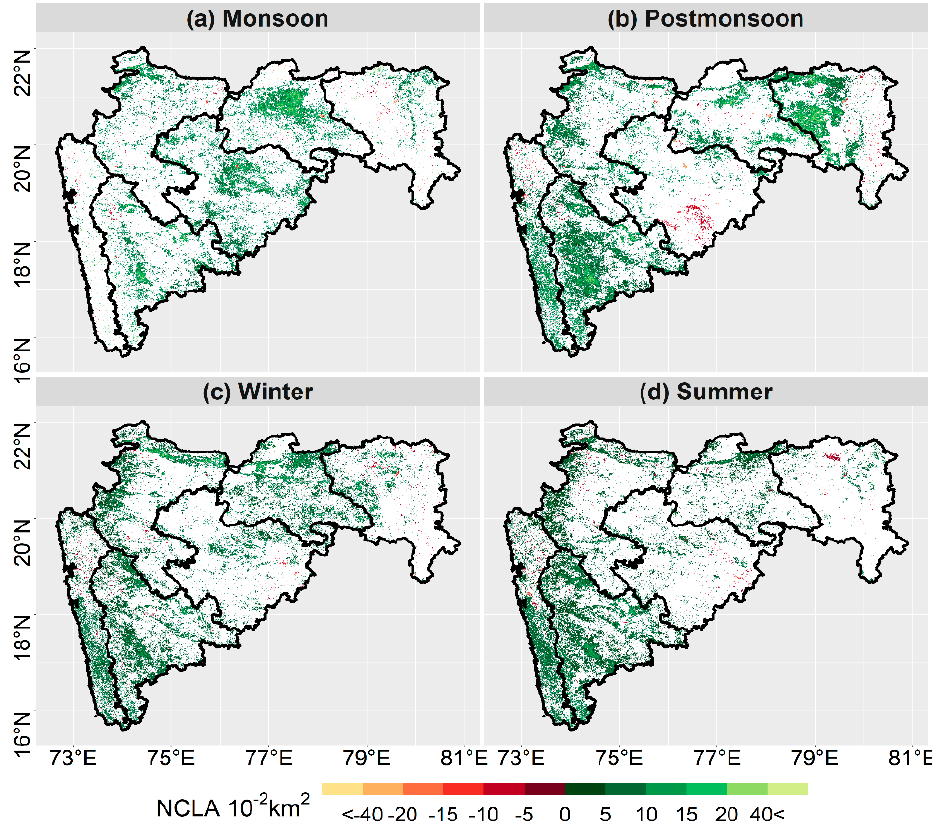
Figure 5. Net change in leaf area (NCLA) by MK trend analysis ( p < 0.05) of seasonal LAI time